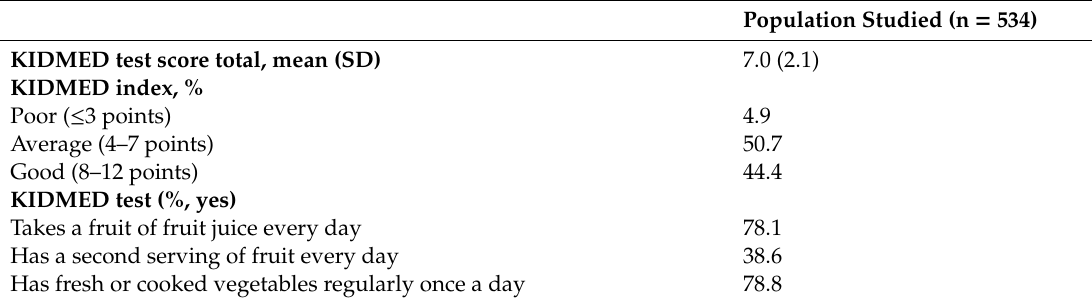
Table 2. KIDMED Score, index, and frequencies of response to each item of the